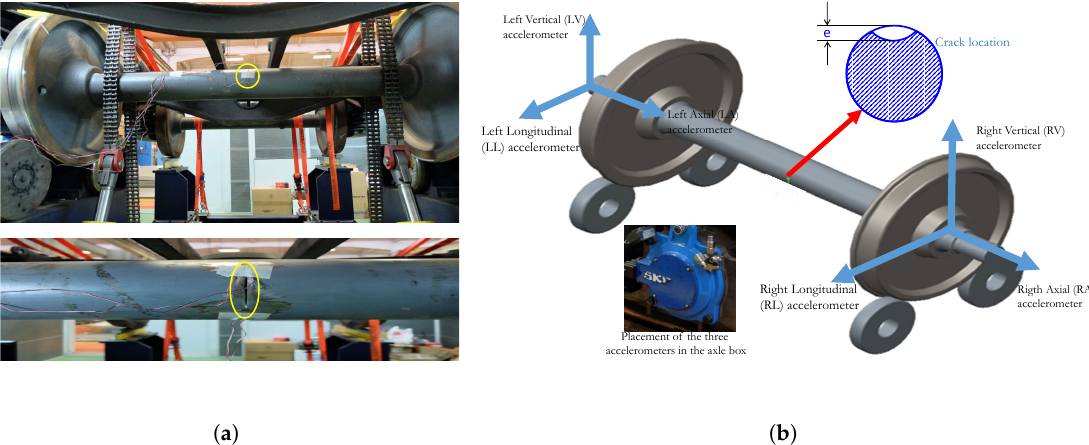
Figure 2. Location of accelerometers and crack fault. ( a ) Location of the crack in the railway axle. ( b ) Location of accelerometers and crack